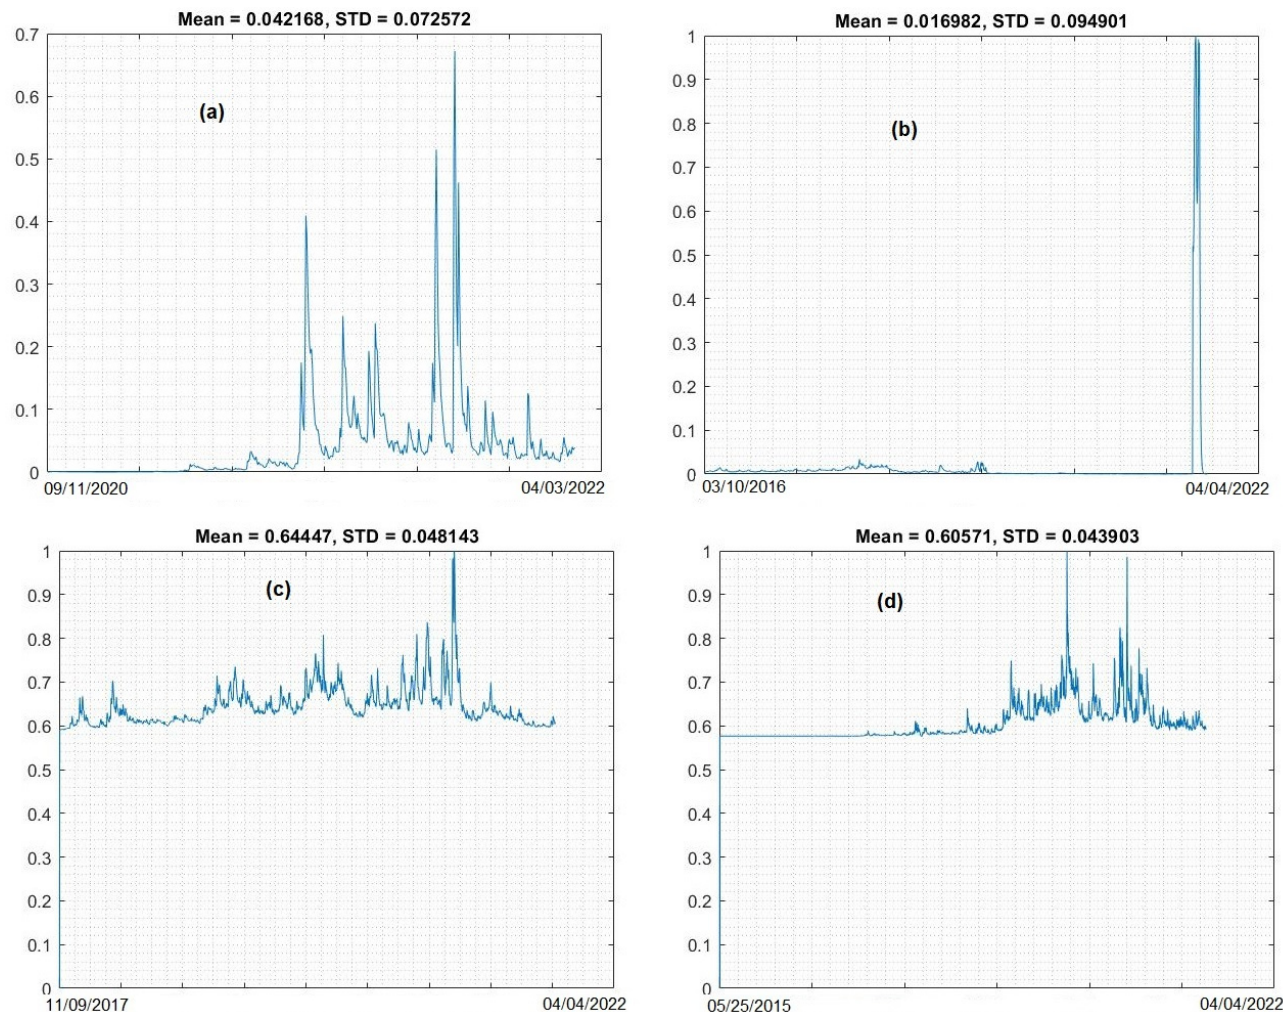
Figure 3. Normalization cryptocurrency data sets: ( a ) AMP, ( b ) Ethereum, ( c ) EOS, and ( d ) XRP.